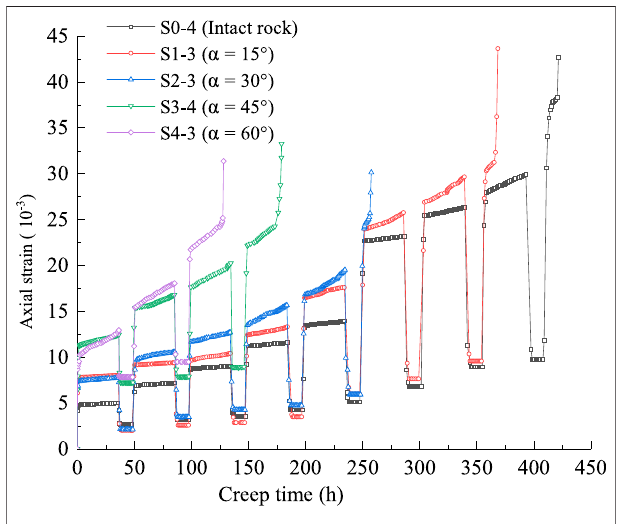
FIGURE 8 | Strain – time curves of specimens from the fi rst to the last stress levels.